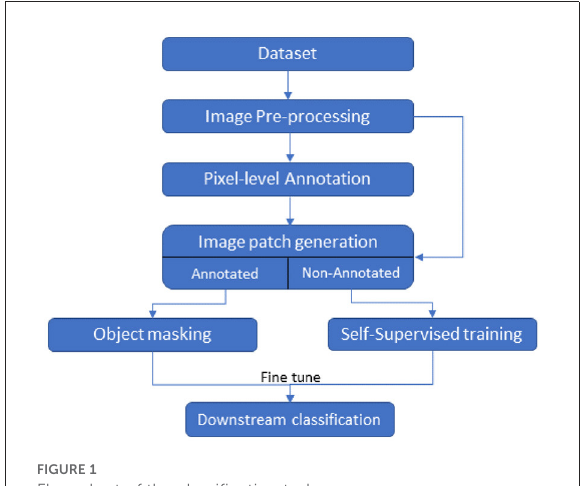
FIGURE1 Flow chart of the classification